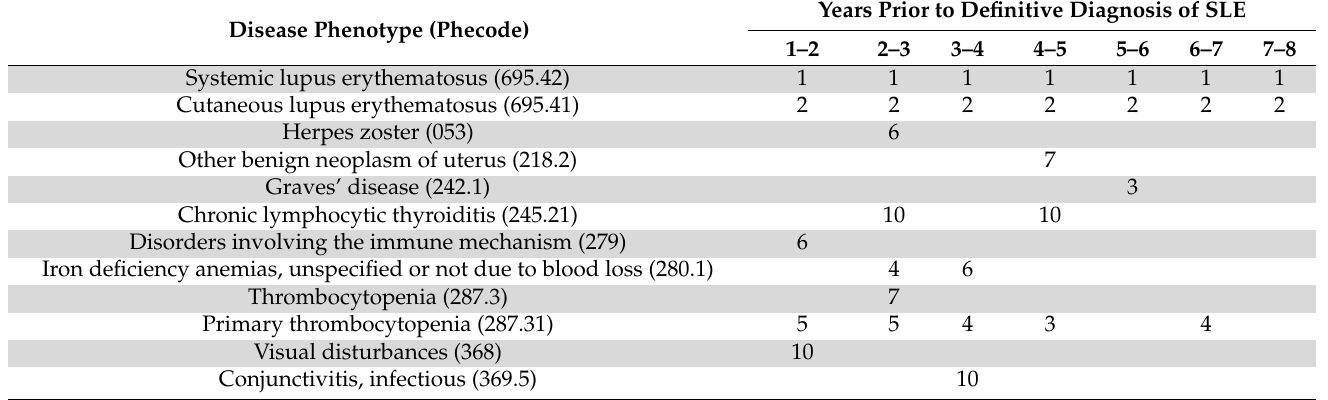
Table 2. Top 10 disease phenotypes within each lag period that were associated with outpatient medical visits in women with systemic lupus